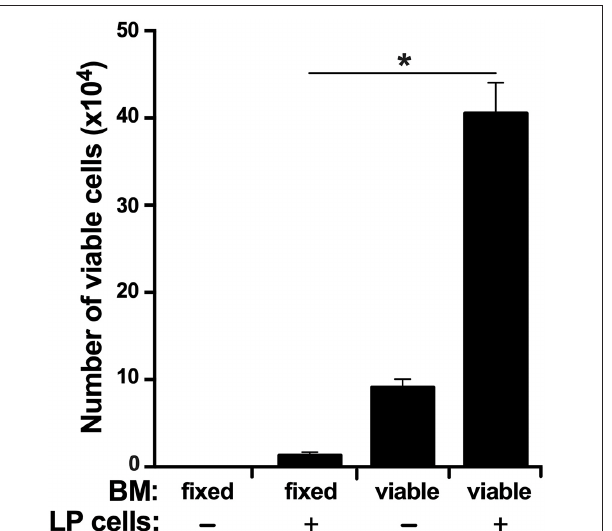
FIGURE 7 | The X. laevis bone marrow supports the survival of liver periphery cells. The frog femurs were isolated and cut at the condyles on one side of each bone to create an opening. One femur from each animal was flushed with saline and the other with methanol to fix the stromal/supportive cells. Liver periphery (LP) cells (10 5 cells per femur from the same respective animals) were introduced into each of the femurs and placed in semi-solid medium with the open-end facing up. After 3 days of incubation, the viable cells in these femurs were enumerated. Results represent combined data derived from three independent such experiments, each experiment assessing tissues/cells from six individual frogs ( N = 6 per experiment; N = 18). Results are means ± SEM and (*) overhead of horizontal lines denote statistical significance, P <